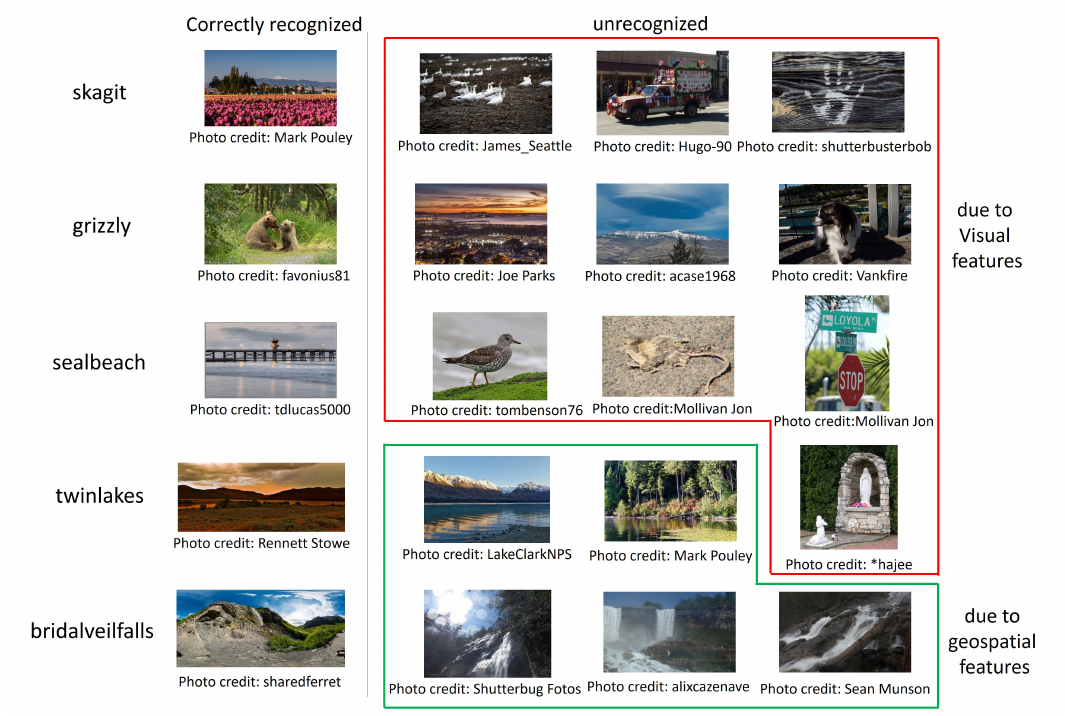
Figure 16. Examples of geospatial concepts whose test images were only partly correctly